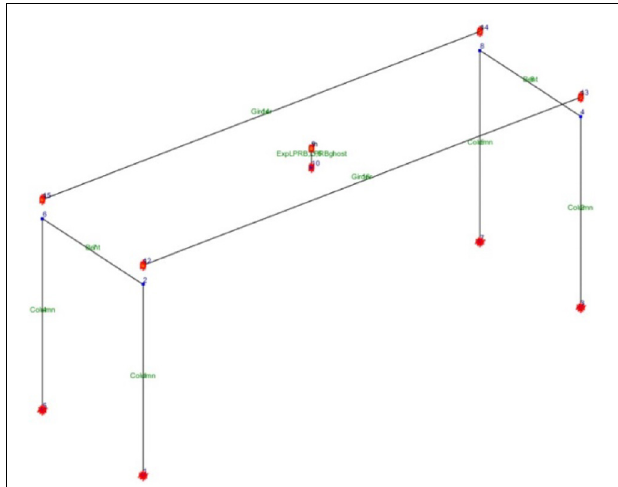
FIGURE 4 | FE model.